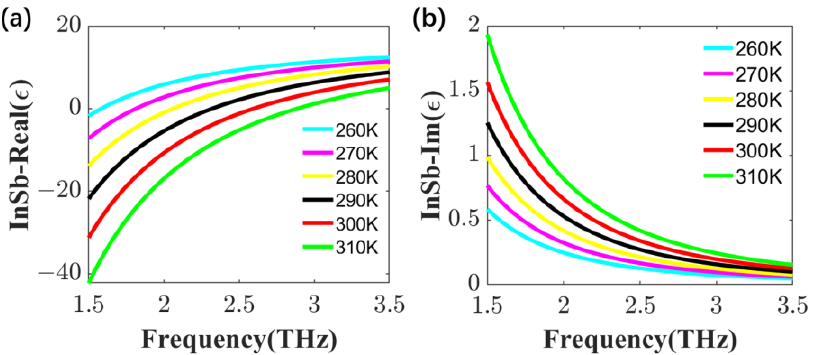
Figure 2. Real ( a ) and imaginary ( b ) parts of the dielectric constant of InSb at different temperatures. In the THz region, the optical properties of graphene also depend on temperature [26]. As Keshavarz proposed that the spectral shifts induced by the temperature change of InSb and graphene are in the same direction [17], it can be speculated that if both of them are present in the sensor structure, the sensitivity will increase significantly. There- temperature sensitivity.